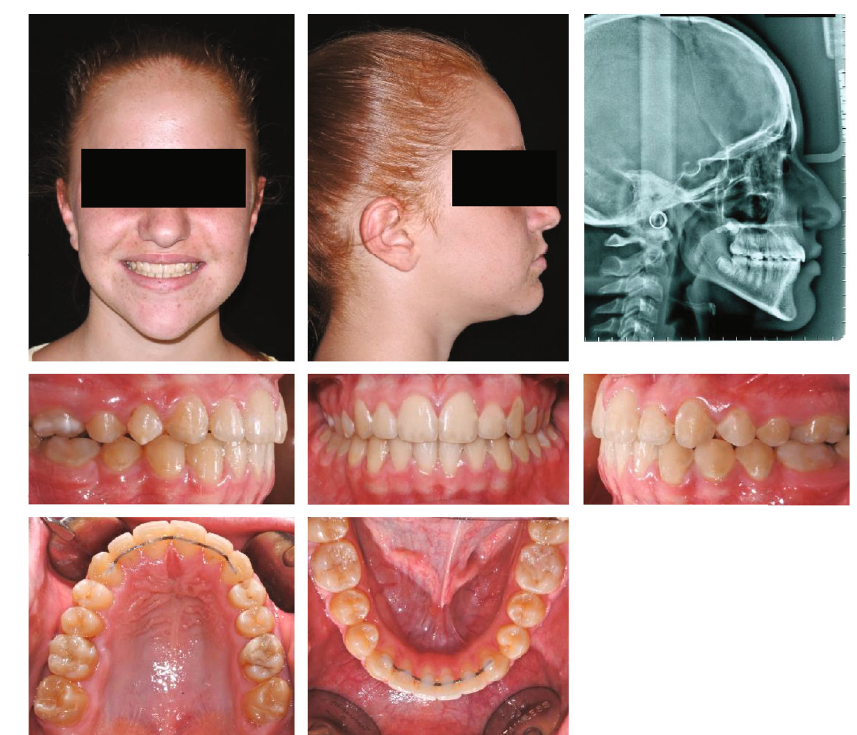
Figure 7: Case no. 1 facial photos, intraoral photos, and lateral cephalogram at T